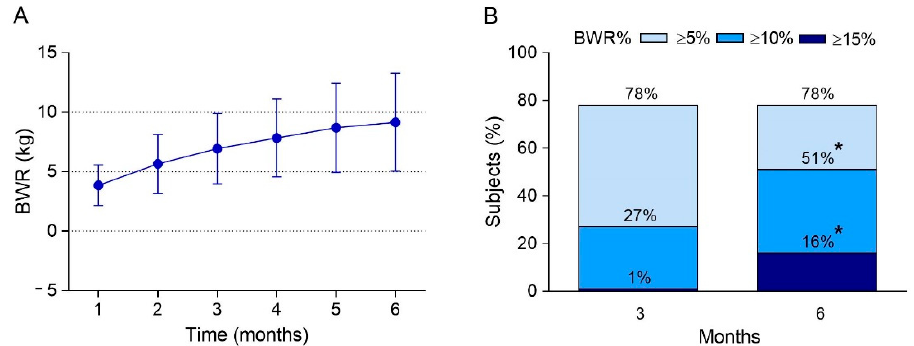
Figure 1. Six-month trends of mazindol effect on body weight reduction (BWRkg) of 196 subjects. Each point represents the mean and standard deviation (Panel A ). Three- and six-month percentage of subjects achieving a ≥ 5%, ≥ 10% and ≥ 15% body weight reduction (Panel B ). Abbreviations. BWR%: body weight reduction in percentage; kg: kilograms, SD: standard deviation, * Significantly different by Fisher’s test ( p < 0.05).